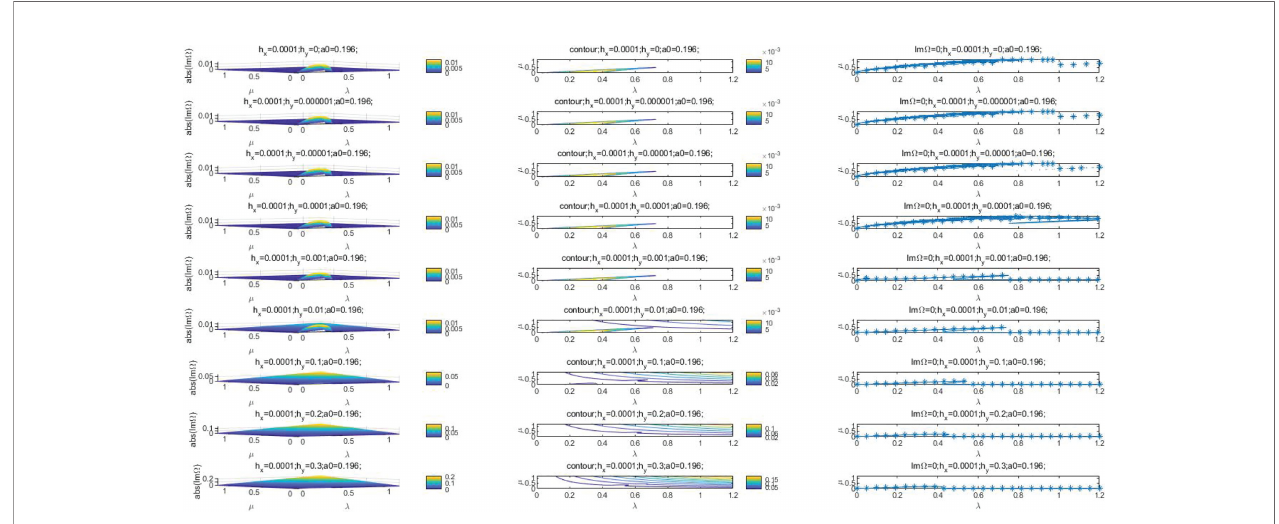
FIGURE 5 | Curves of ǀ Im W ǀ and Im W = 0 for a 0 = 0.196 and ∂ h ∂ x = 0 : 0001.